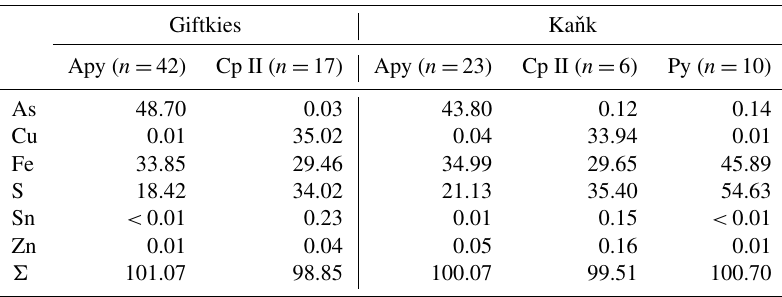
Table 2. Mean values of EMP analyses of nominally Sn-free sulfides of Giftkies and Kaˇnk (apy, arsenopyrite; cp II, chalcopyrite II; py, pyrite). Values are given in percent by weight (wt%). All analyses are listed in Table